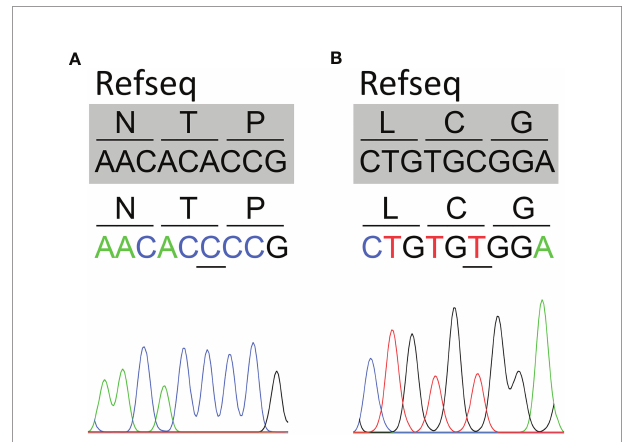
FIGURE 1 | Identi fi cation of synonymous SLC5A5 variants in patients with dyshormonogenic congenital hypothyroidism. Partial sequence chromatograms covering the region of the variants (underlined) in exons 11 (c.1326A>C) (A) and 13 (c.1626C>T) (B) of the SLC5A5 gene. The reference sequence (Refseq) is indicated in